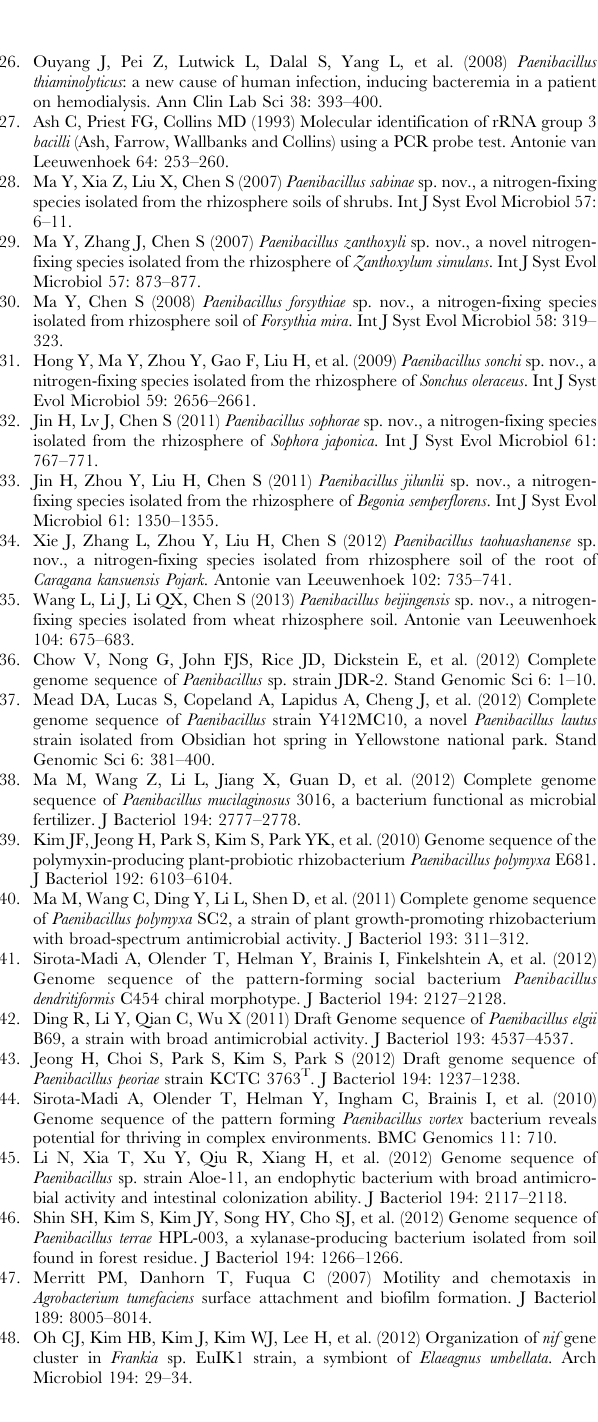
Table S4 Prophages present in the genomes of 31 Paenibacillus strains. The following information is provided for each prophage: insertion site, size, locus tags, and selected cargo genes. Table S5 The nitrogen fixation genes and nitrogenase-like genes in the nitrogen-fixing Paenibacillus strains. Table S6 Average Nucleotide Identity (%) based on whole genome